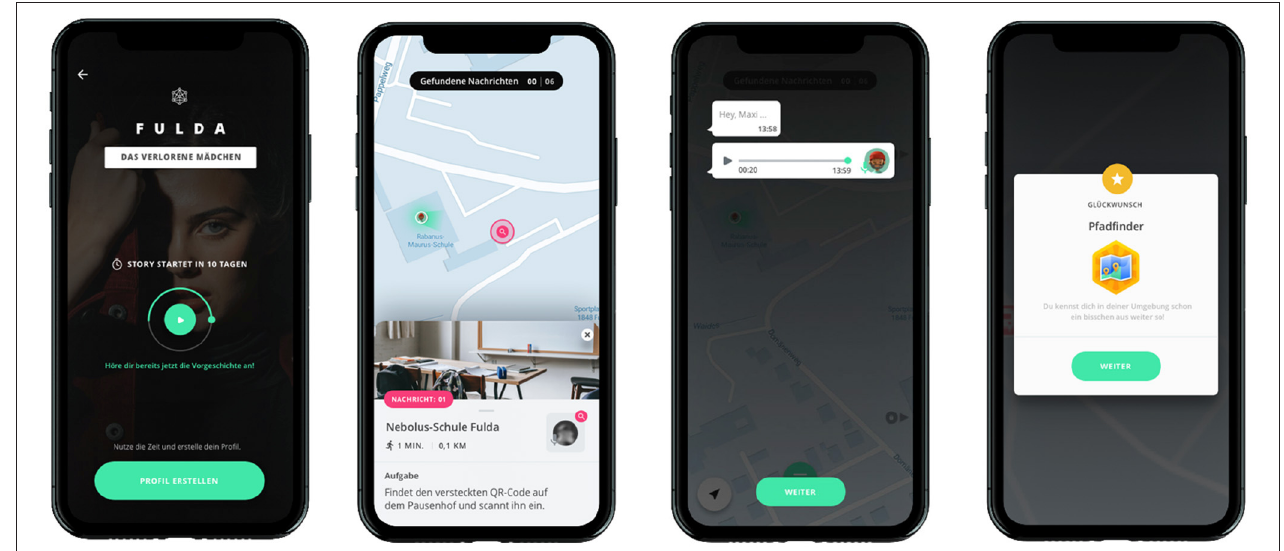
FIGURE 2 | Impressions of the Nebolus LbG